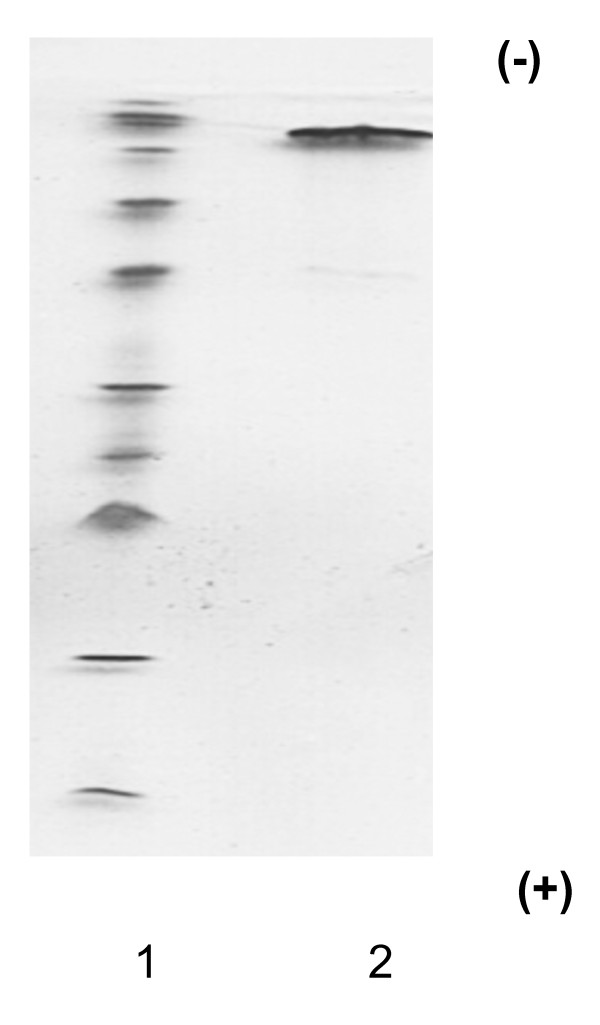
IEF-PAGE of purified chicken CA-III. The single bond of purified chicken CA-III was observed. Lane 1, high pI calibration markers. The high isoelectric point kit contains β-lactoglobulin A (5.20), bovine CA-B (5.85), human CA-B (6.55), horse myoglobin-acidic band (6.85), horse myoglobin-basic band (7.35), lentil lectin-acidic band (8.15), lentil lectin-middle band (8.45), lentil lectin-basic band (8.65), and trypsinogen (9.30); lane 2, chicken CA-III.